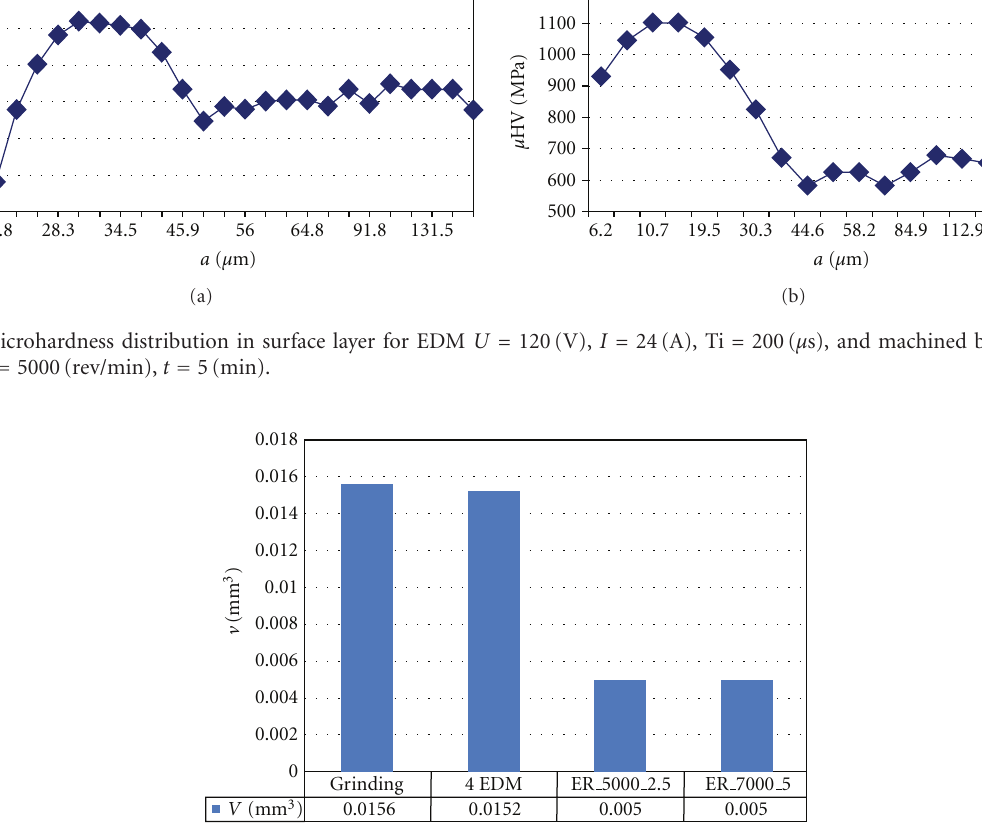
Figure 8: Specification of the resulting resistance to abrasive wear for friction with lubrication of the samples of tool steel NC10 machined by grinding and by the EDM: U = 80(V), I = 48 (A), Ti = 400 ( μ s), and EDM + roto-peen: n = 5000 (rev/min), t = 2 . 5 (min), and n = 7000 (obr/min), t =